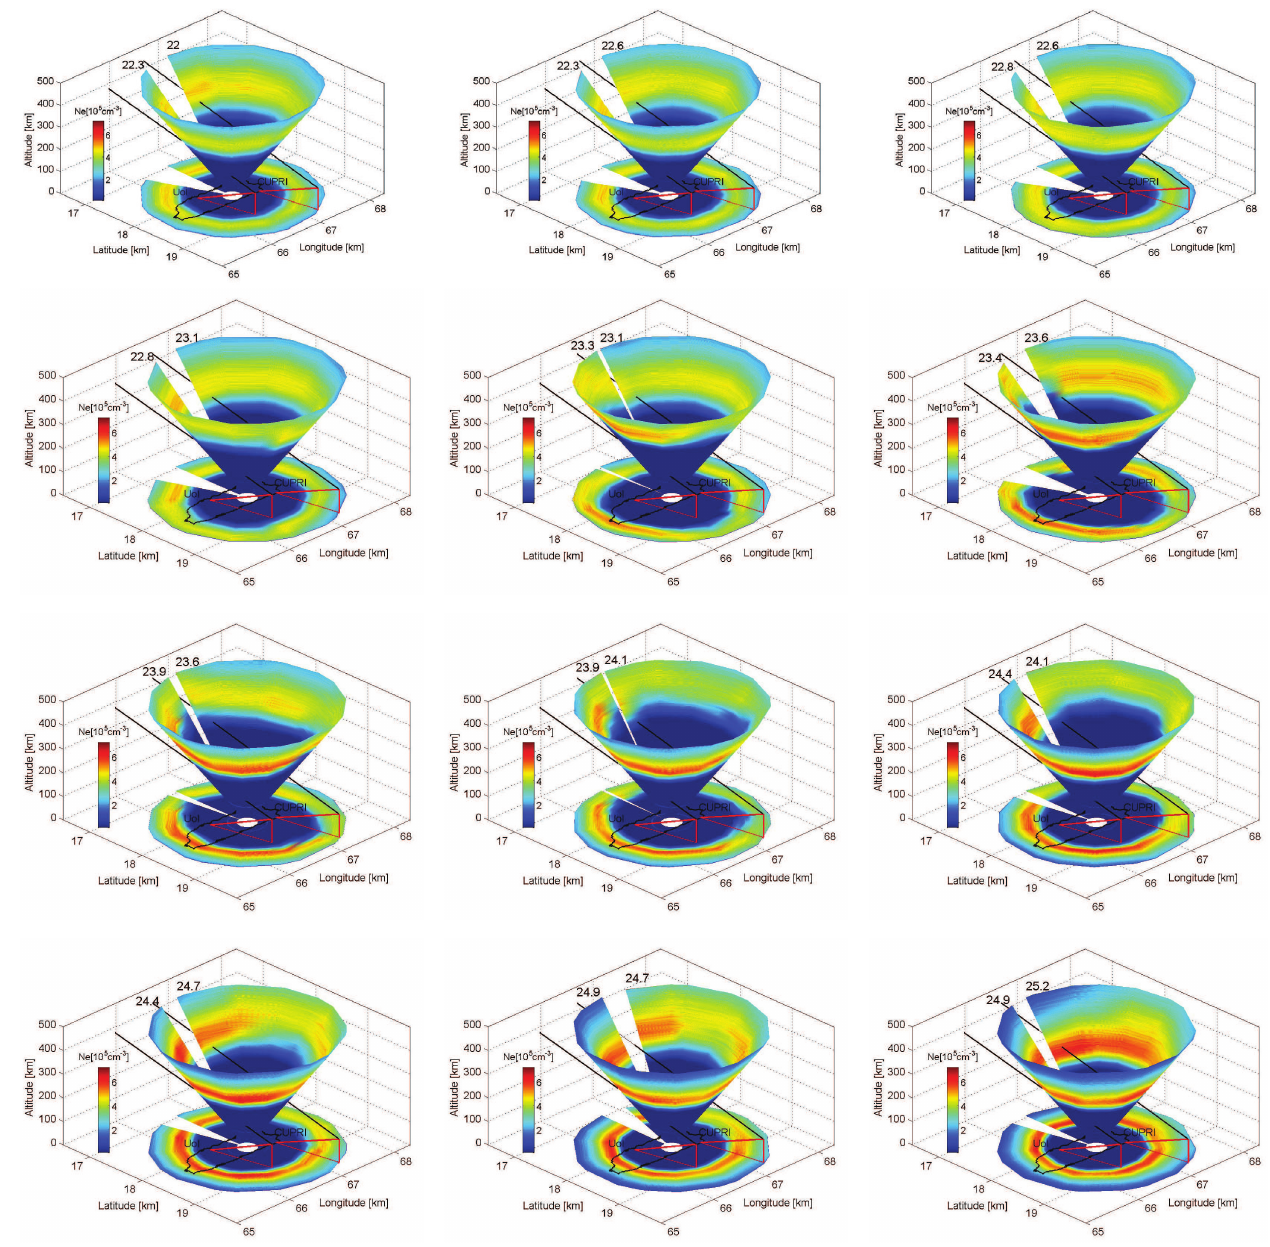
Fig. 3. Shown is a time sequence of sequential back-and-forth azimuth scan cones of the Arecibo electron density measurements from 55km to 500km together with the beams of the CUPRI and Illinois radars to 100 km altitude and the intersecting magnetic field lines. Time progresses from left-to-right and from top-to-bottom with beginning and ending times in decimal hours. Projections of the density cones are shown on the ground along with the outline of the island of Puerto